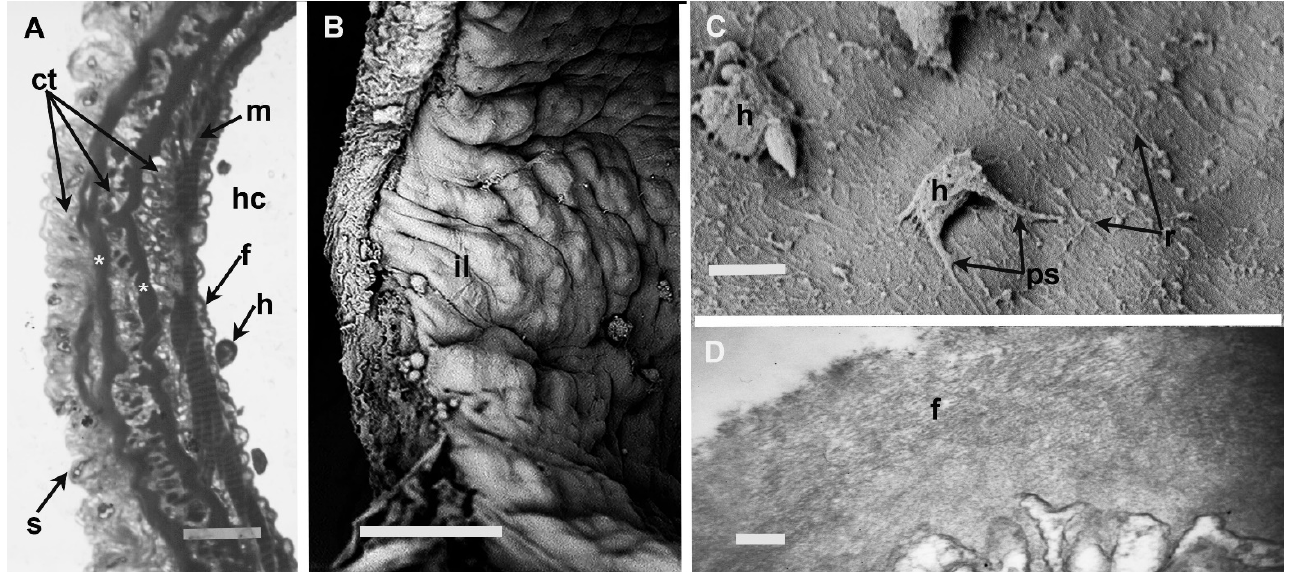
Figure 2. Inner lining of the dorsal abdominal artery. ( A ) Light micrograph of cross section through vessel wall showing inner lining of fibrillin-like material (f) separating the hemocoel (hc) and a hemocyte (h) from three wall layers of connective tissue (ct), separated by two additional layers of fibrillin (*), each outside of a muscle layer (m). An outer connective tissue sheath (s) surrounds the entire vessel. ( B ) Low magnification view of inner vessel lining (il) showing folded surface. ( C ) Higher magnification view of inner fibrillin surface and attached hemocytes (h) with extended pseudopodia (ps) tapering to diameters like small ridges (r) running parallel to long axis of vessel. ( D ) Transmission electron micrograph showing the weave of filaments in the fibrillin layer (f) covering a ridge on the surface. Scale bar ( A ) 50 µm, ( B ) 50 µm, ( C ) 10 µm, ( D ) 0.25 µm.